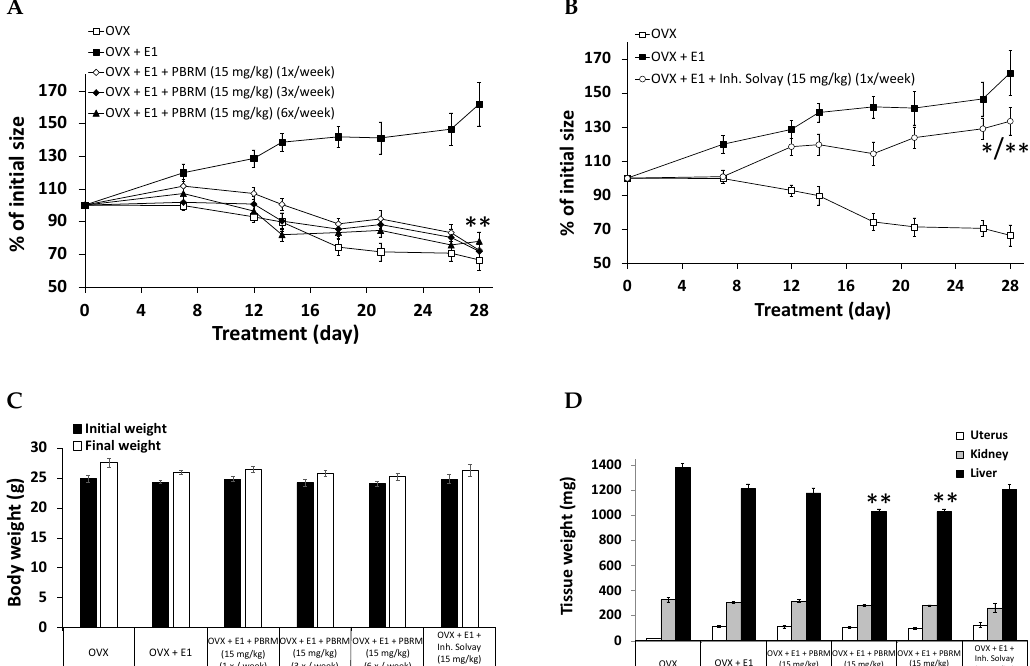
Figure 5. ( A ) Inhibition (%) of breast cancer tumor growth (T-47D xenografts) stimulated by E1 injected SC six days a week in nude mice. Irreversible inhibitor PBRM (15 mg/kg) was solubilized in sunflower oil:EtOH (92:8) and administered PO (gavage) at three different frequencies (1, 3 and 6 times/week). The reversible Solvay’s inhibitor (compound 21 in [57]) (15 mg/kg) was solubilized in sunflower oil:EtOH and administered PO at a frequency of 1 time/week. (**) p < 0.01 vs. OVX + E1 at 12, 14, 18, 21, 26 and 28 days. ( B ) Inhibition (%) of breast cancer tumor growth (T-47D xenografts): Comparison between both types (reversible and irreversible) of 17 β -HSD1 inhibitors (15 mg/kg) at the lower frequency of administration (1 time/week). (*) p < 0.05 vs. OVX + E1 and (**) p < 0.01 vs. OVX at 12, 14, 18, 21, 26 and 28 days. ( C ) Body weight of mice from the protocol reported in ( A , B ). No significant difference between PBRM-treated groups and untreated group (OVX + E1). ( D ) Uterus, kidney, and liver weights of mice treated in the protocol reported in ( A , B ). No significant difference between the treated groups and untreated group (OVX + E1) except for liver (**) p < 0.01 vs. OVX + E1.